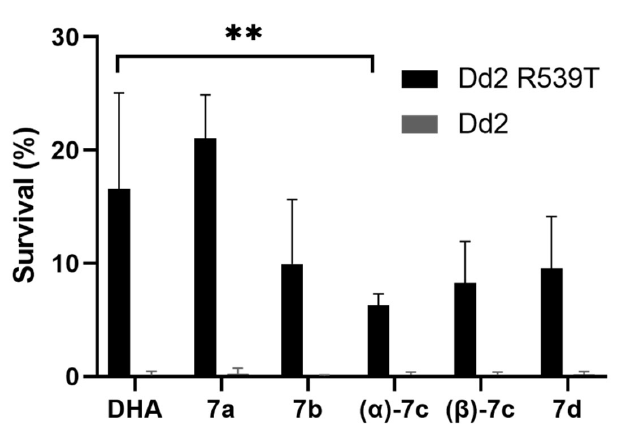
Figure 4. Survival of the artemisinin-resistant (Dd2 R539T) and sensitive (Dd2) P. falciparum line after treatment with 700 nM of the respective compound (DHA or DHA–HDACi hybrid) in the ring-stage survival assay. Results show the survival in percent of the drug-treated parasites in relation to the untreated control (DMSO) parasites. Each experiment was performed twice in duplicate. All compounds, except 7a , were slightly more active, with ( α )- 7c being significantly more active than DHA alone (unpaired t ‐ test: ** p < 0.005)